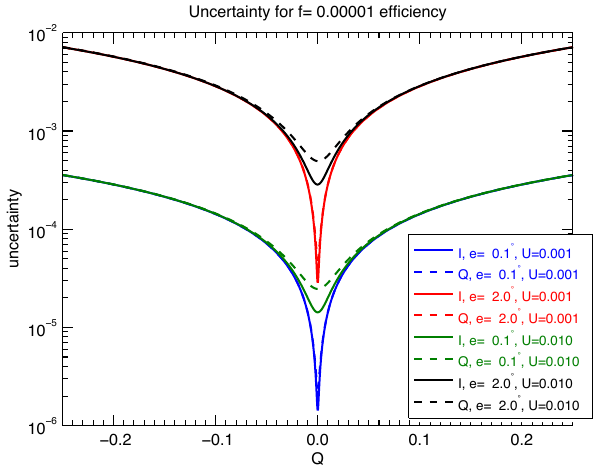
Figure A1. Polarimetric uncertainty in reflectance units for a scene with I = 0 . 5, θ s = 45 ◦ , and f = 10 − 5 , and various values of Q , U , and e